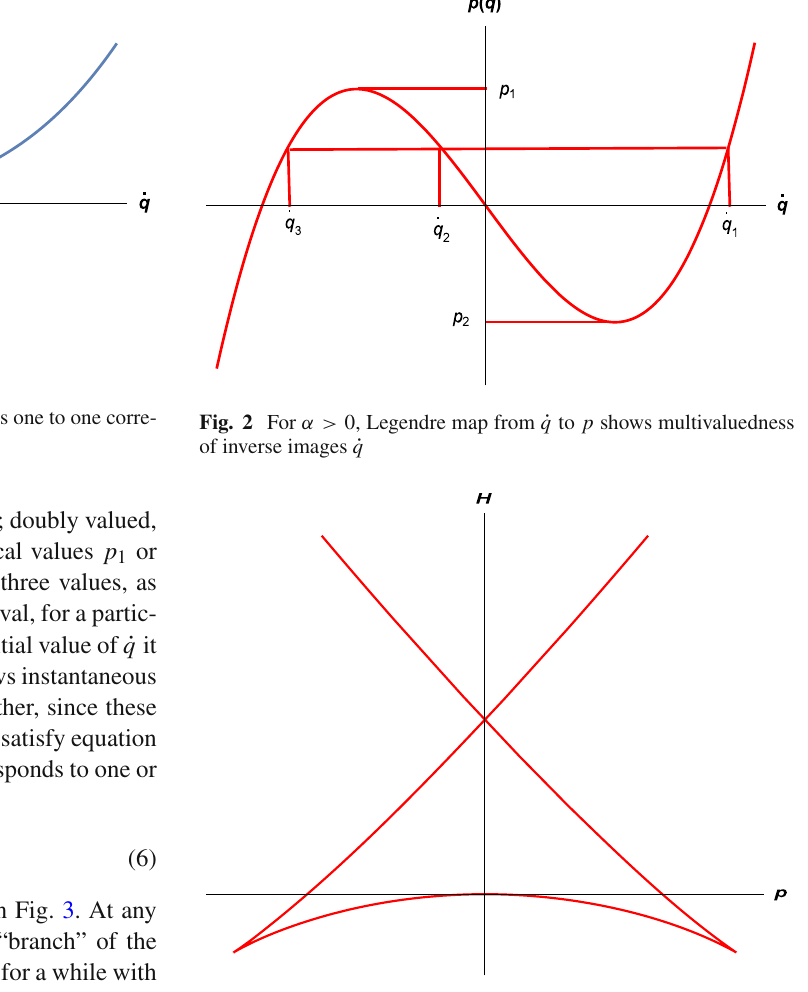
Fig. 3 Phase-space portrait depicts the multivaluedness of the Hamil- tonian H with